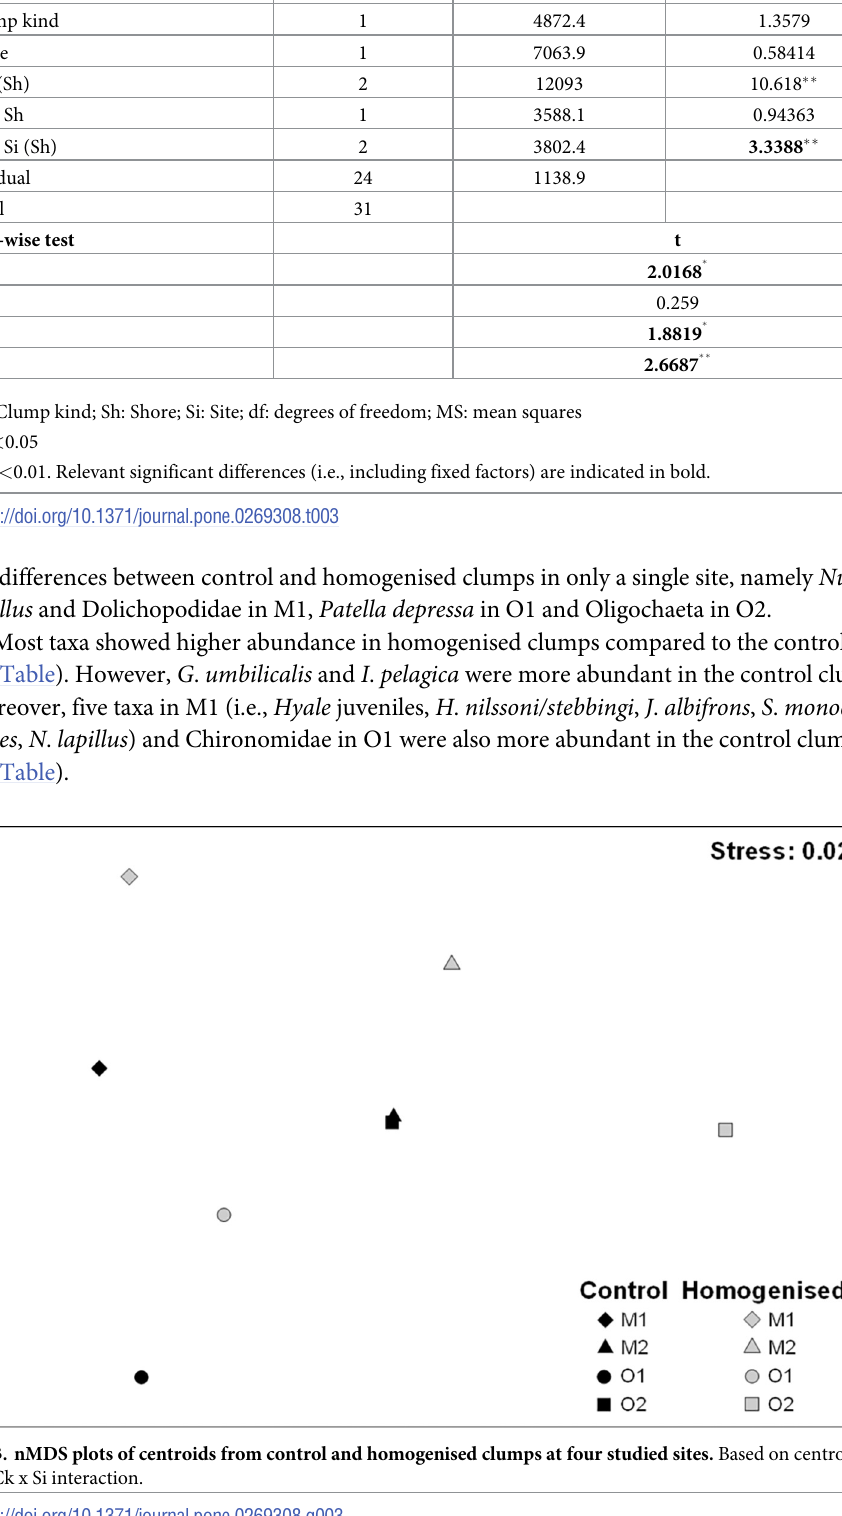
Fig 3. nMDS plots of centroids from control and homogenised clumps at four studied sites. Based on centroids for the Ck x Si